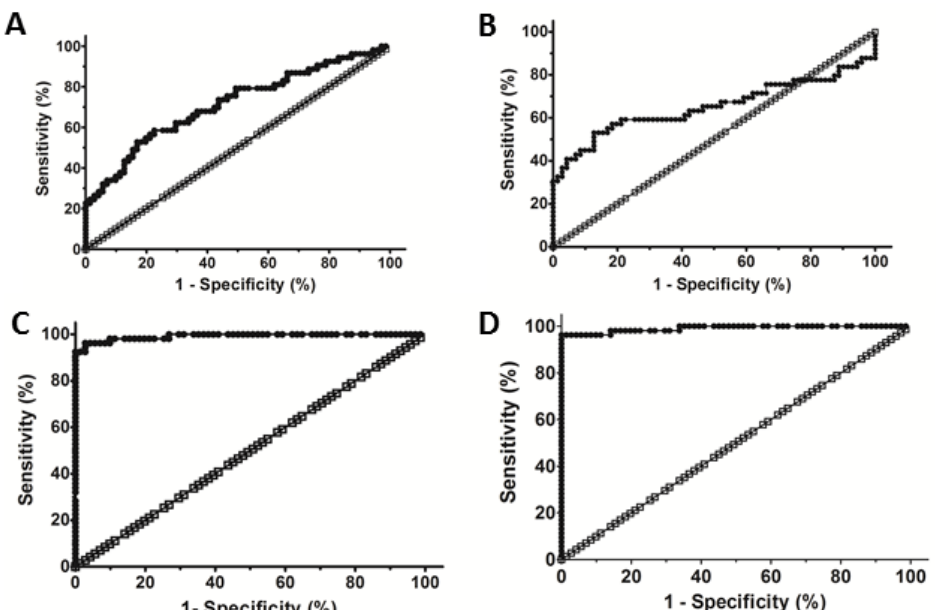
Figure 2. Diagnostic accuracy of APRI, FIB4 and levels of cathepsin B (Cat B) and plasma kallikrein (PKa) in CHC patients. Receiver-operating characteristic (ROC) curves were created to determine the AUROC using APRI, FIB-4 and levels of Cat B and PKa to predict hepatic fibrosis. ( A ) Evaluation of the diagnostic capacity of the APRI. (AUROC = 0.71 ± 0.05; 95%CI = 0.621–0.807; p < 0.0001; N = 124). ( B ) Evaluation of the diagnostic capacity of FIB4. (AUROC = 0.67 ± 0.06; 95%CI = 0.525–0.817; p < 0.0001; N = 124). ( C ) Evaluation of the diagnostic performance of Cat B. (AUROC = 0.99 ± 0.02; 95%CI = 0.9803–1.003; p < 0.0001; N = 124). ( D ) Evaluation of the diagnostic performance of PKa. (AUROC = 0.991 ± 0.007; 95%CI = 0.9770–1.005; p < 0.0001; N = 124). The white symbols correspond to diagonal of roc curve, where sensibility is equal to specificity, that means everyone has the same probability (50%).